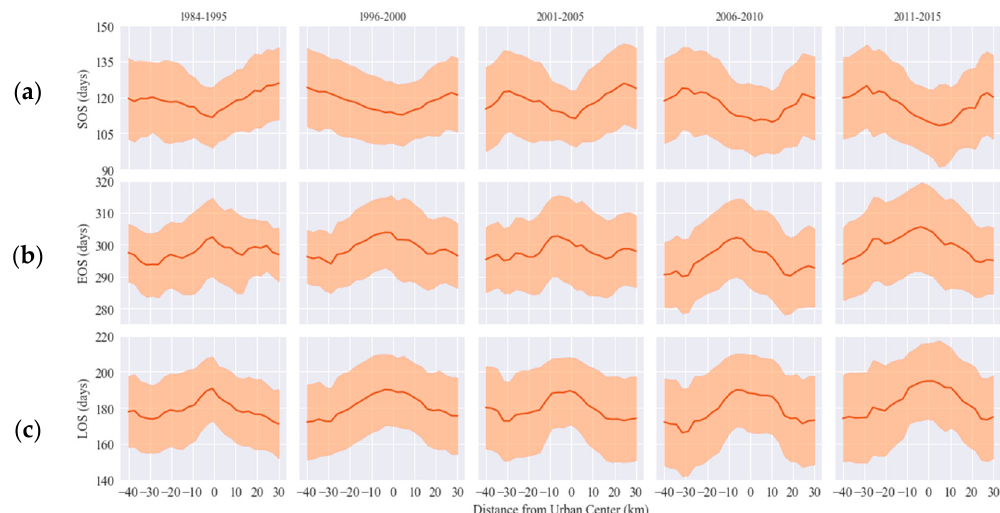
Figure 7. Spatial mean SOS ( a ); EOS ( b ) and LOS ( c ) for urban vegetation as a function of distance along the east-west transect that runs through the urban center. The columns represent the periods: 1984–1995, 1996–2000, 2001–2005, 2006–2010, and 2011–2015. Bold lines represented average SOS, EOS, and LOS and shaded areas represented ± one standard deviation within each 5 km blocks.